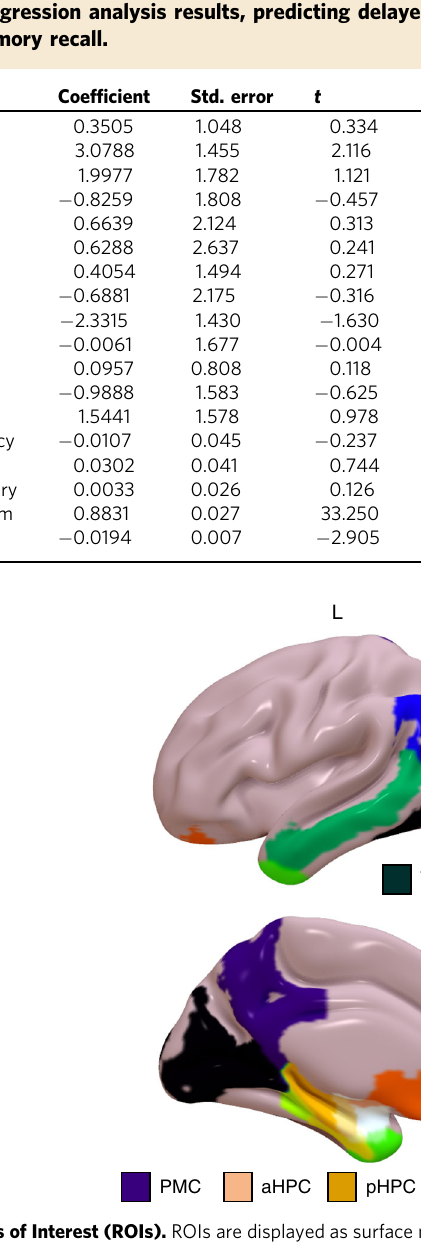
Fig. 4 Regions of Interest (ROIs). ROIs are displayed as surface maps normalized to MNI space. VC = visual cortex, ANG = angular gyrus, MTG = middle temporal gyrus, PMC = posterior medial cortex, HPC = hippocampus (anterior/posterior subdivisions not displayed here), PHC = parahippocampal cortex, PRC = perirhinal cortex, AMY = amygdala, TP = temporal pole, mPFC = medial prefrontal cortex).